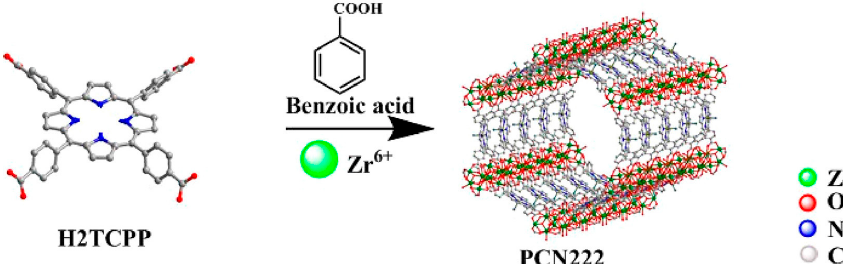
Figure 13. Schematic diagram of PCN222 preparation process. Reprinted with permission from ref [59]. Copyright 2019 American Chemical Society.